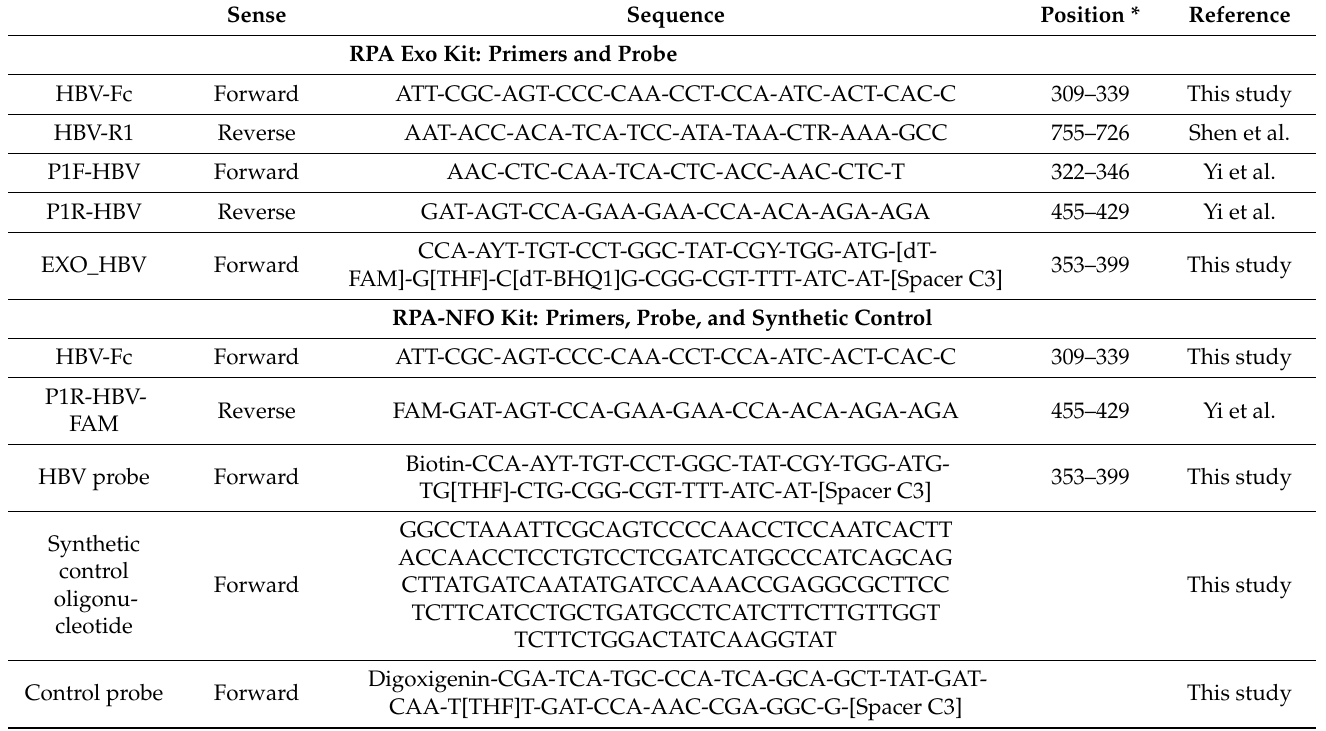
Table 1. Primers and probes used in this